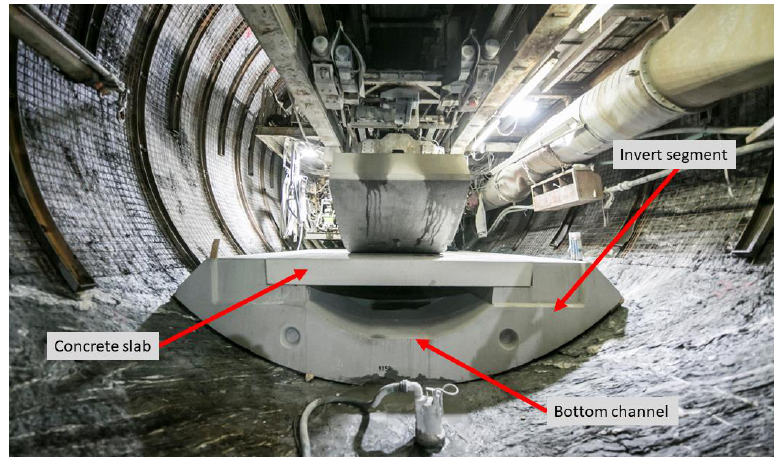
Figure 5. Invert segment with bottom channel and concrete slab (taken and modified from [6]).